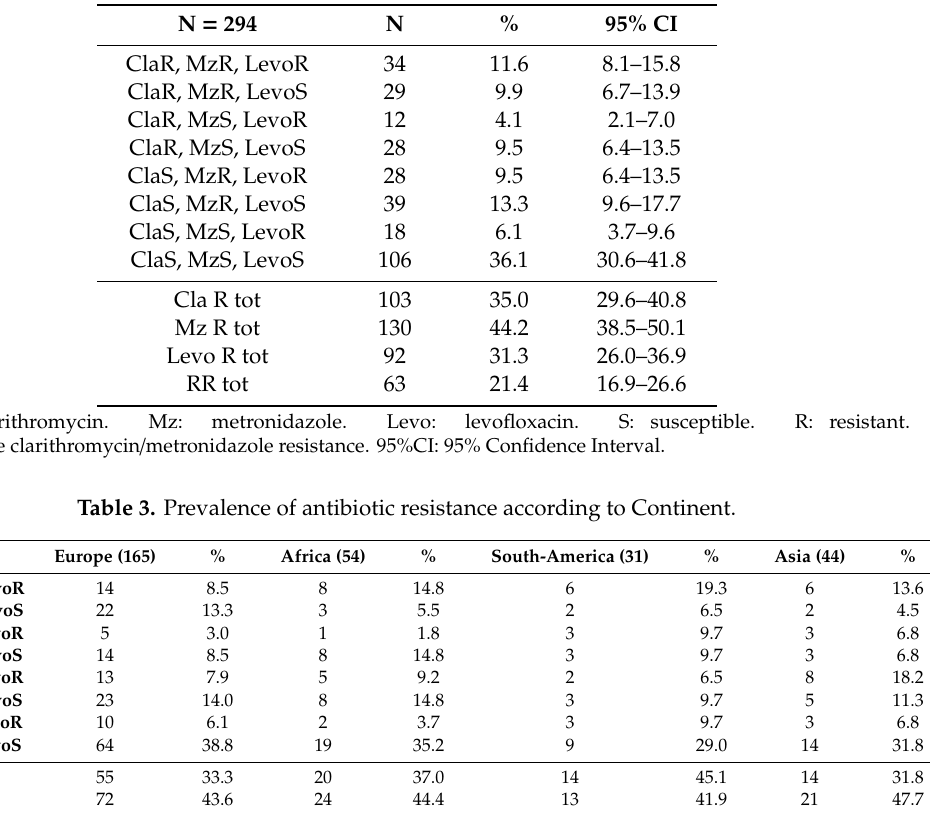
Table 2. Pattern of primary resistance in H. pylori isolates.